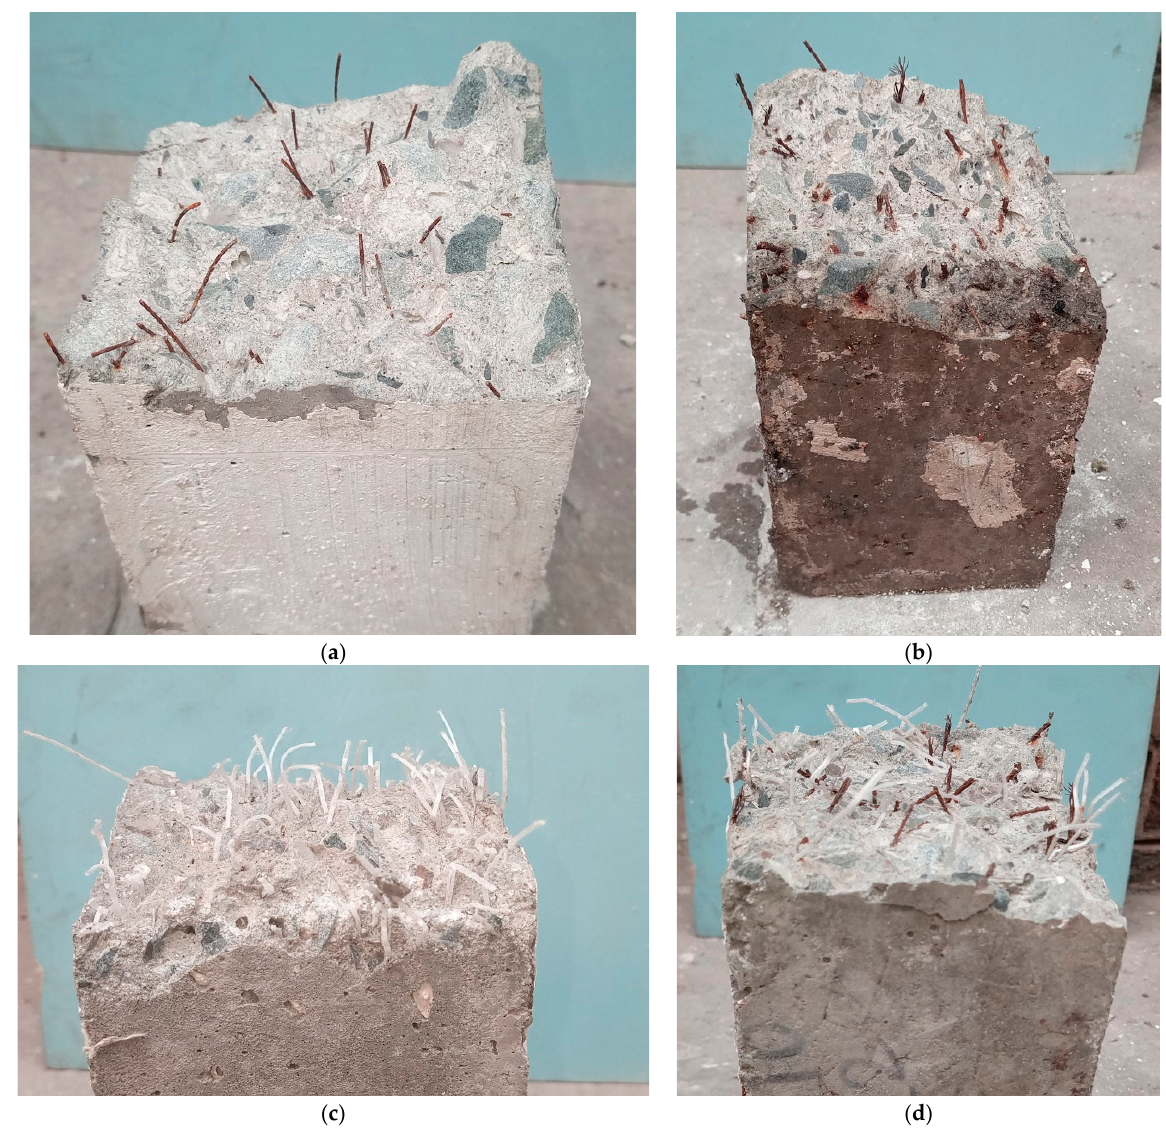
Figure 11. Load vs. crack width recorded at discrete points during the testing for specimen incor ‐ porating ( a ) straight steel fibers, ( b ) bundled steel fibers, ( c ) PP fibers, ( d ) hybrid fibers (bundled steel fibers and PP fibers).